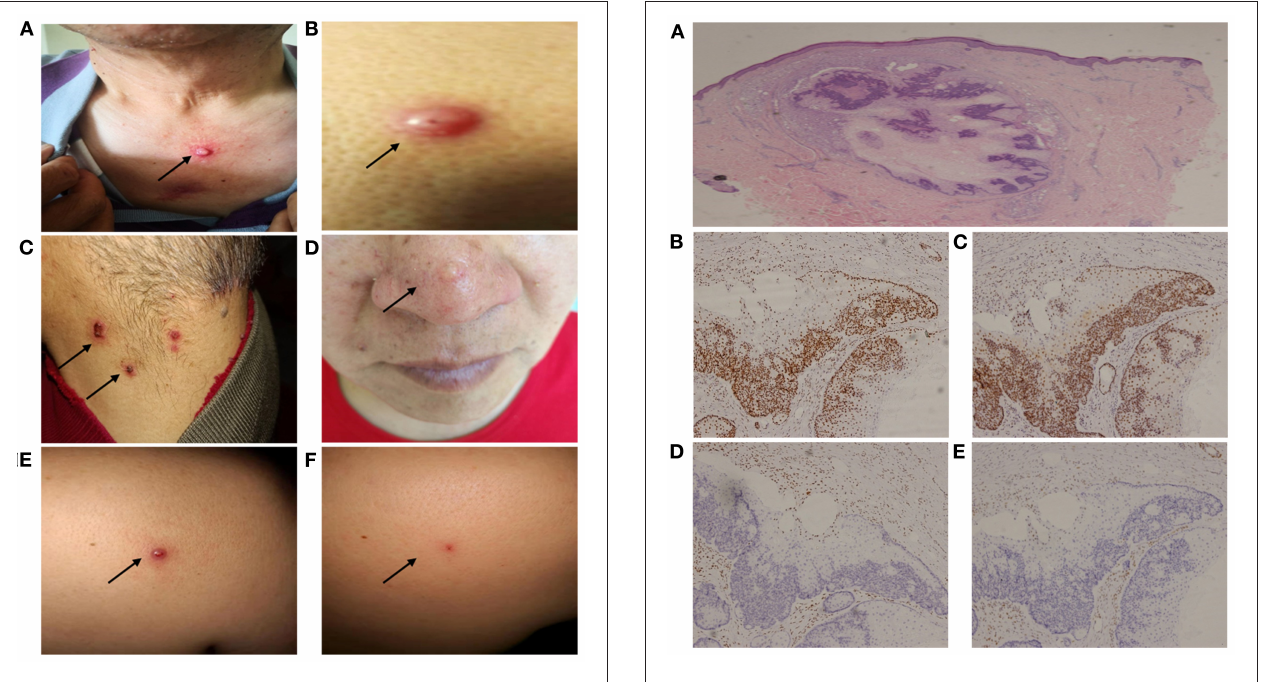
FIGURE 2 | Clinical manifestations of the proband’s skin tumors. The proband presented with recurrent skin tumors on the chest (squamous cell carcinoma) (A) , back (hyperplastic squamous cell carcinoma) (B) , neck (sebaceous adenoma) (C) , face (sebaceous adenoma) (D) . A nodule in the back shoulder before (0.9 × 0.6cm) (E) , and after (0.2 × 0.1cm) (F) immunotherapy.